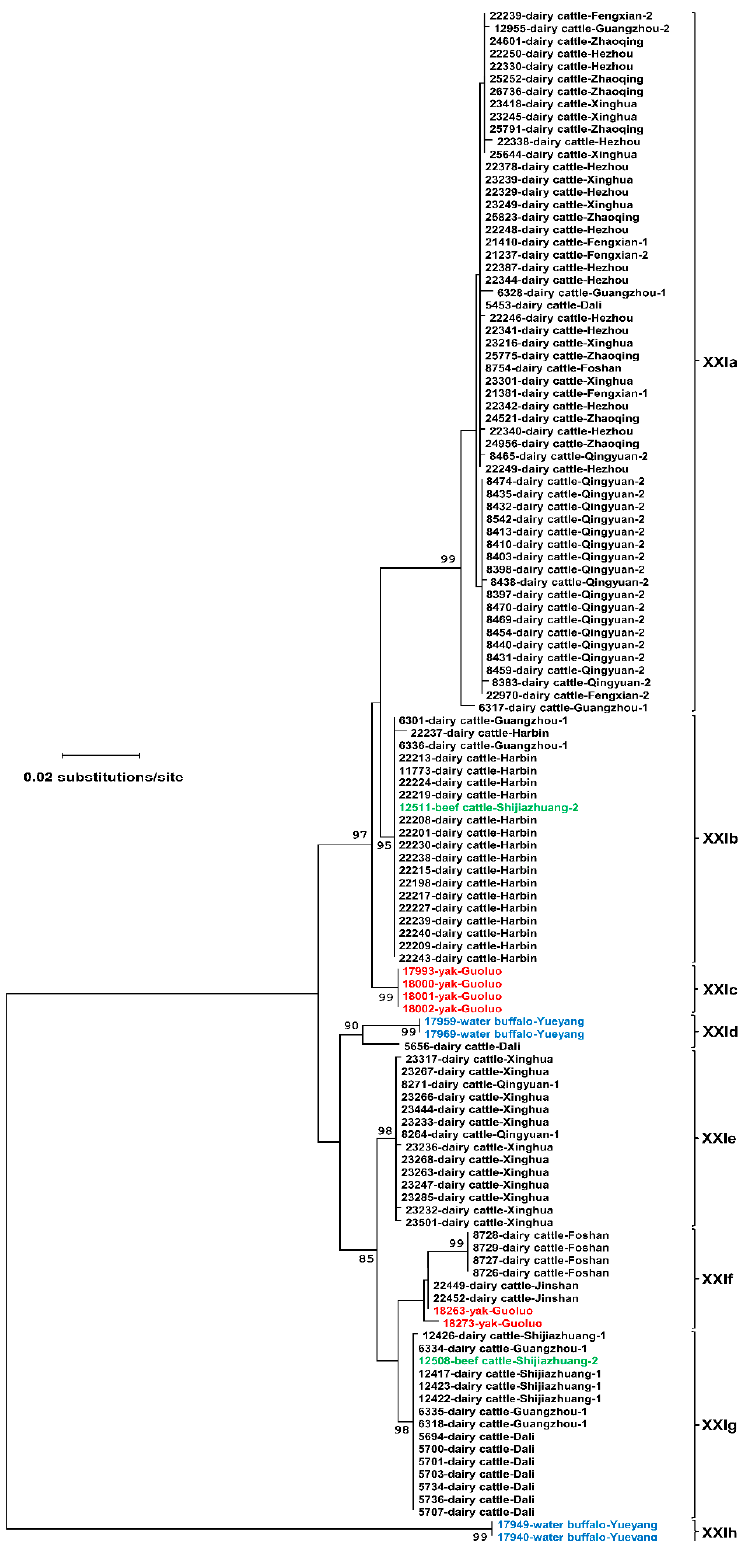
Figure 2. Phylogeny among eight Cryptosporidium ryanae subtype families based on a maximum likelihood analysis of the partial gp60 gene. Sequences from dairy cattle, beef cattle, yaks, and water bu ff aloes are marked in black, green, red, and blue, respectively. Bootstrap values ( > 75) are indicated on branches. Scale bar indicates 0.02 nucleotide substitutions per